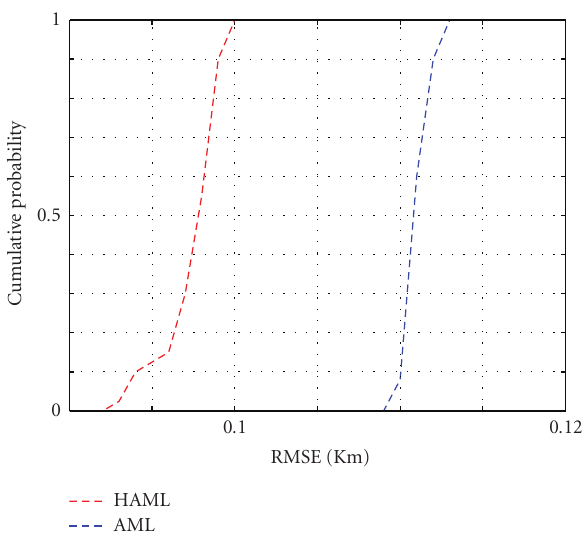
Figure 1: Comparison between 2-BS HAML and 3-BS AML techniques.